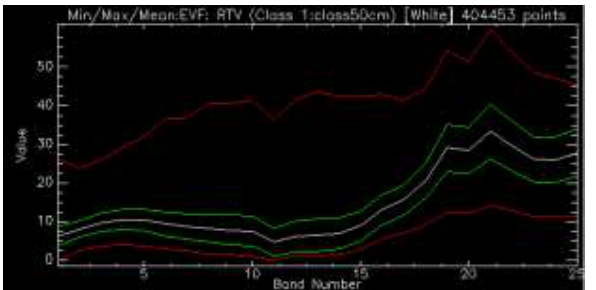
Figure 11. Graphical representation of maximum, minimum (red lines) and mean (white) values of all wavelengths of the sample which represents shadow pixels in the LRcube It is possible to verify that the difference between maximum and minimum values tends to be lower at the limits of the spectral wavelengths of the camera. In fact, the band centred at 519.9